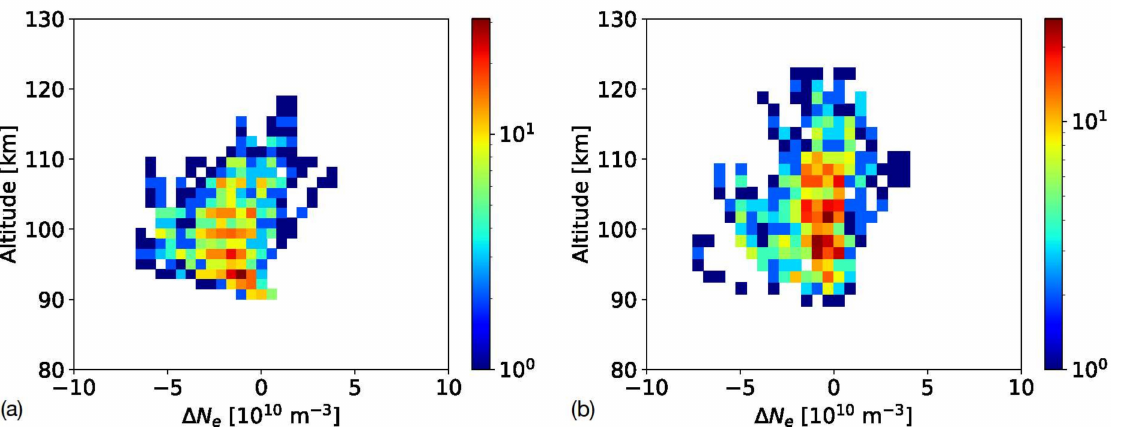
Figure 16. Histograms of the N e difference ( N e,GNSS-RO –N e,ionosonde ) at each GNSS-RO altitude between the f min altitude and h m E . Plot ( a ) shows the unshifted N e differences, while ( b ) shows the shifted profile differences. The color bar corresponds to the number of measurements within each